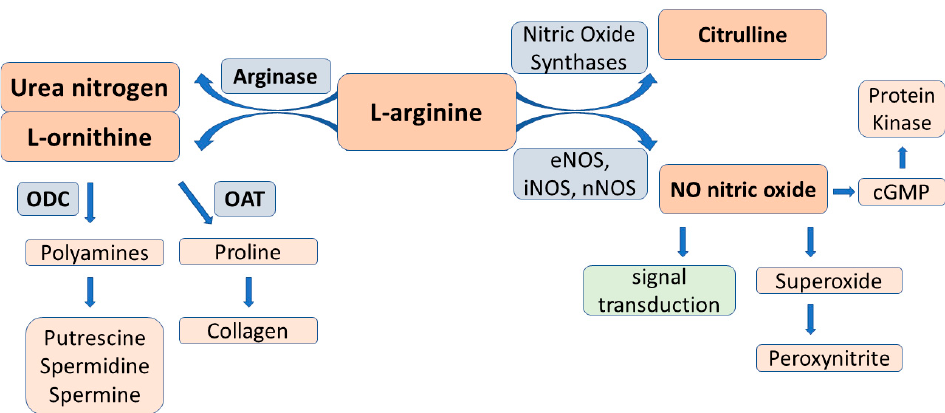
Figure 3. L-arginine catabolism pathways by nitric oxide synthases to nitric oxide and l-citrulline, and by arginase to l-ornithine and downstream metabolites. Abbreviations: eNOS, iNOS, nNOS → endothelial, inducible, and neuronal nitric oxide synthases; ODC = ornithine decarboxylase, OAT = ornithine aminotransferase.